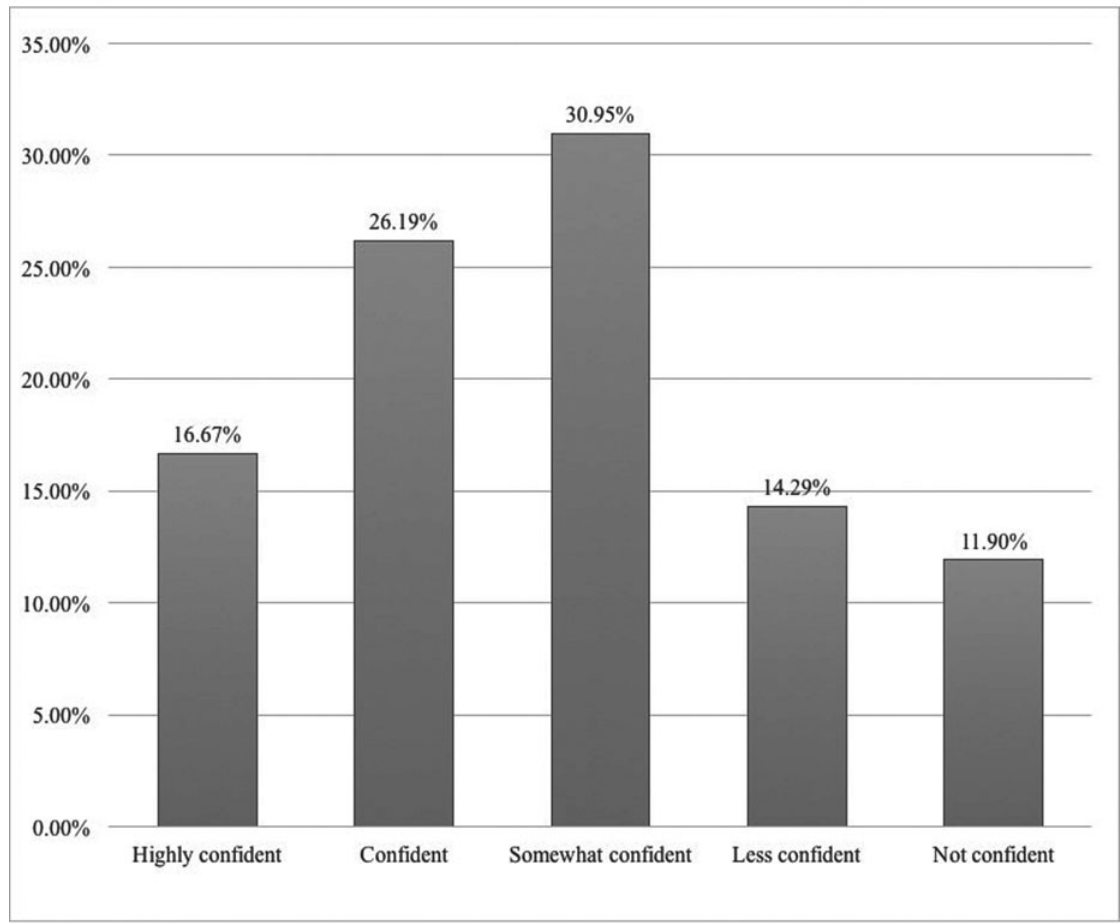
FIGURE 3 Confidence in the understanding of the electoral and voting system. ‘’come vote local” because as an individual you can influence others which they would influence others in a continuous form (Focus Group